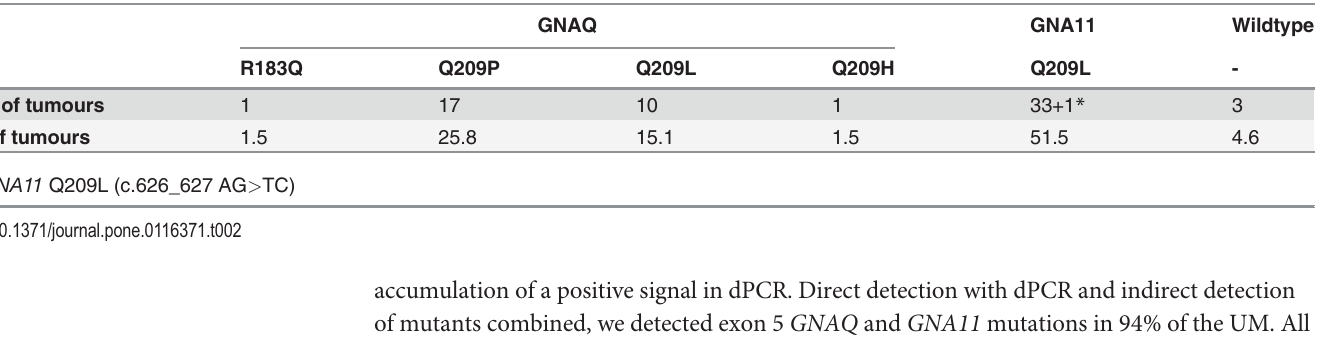
Table 2. Summary of GNAQ and GNA11 mutations detected in 66 UM samples.